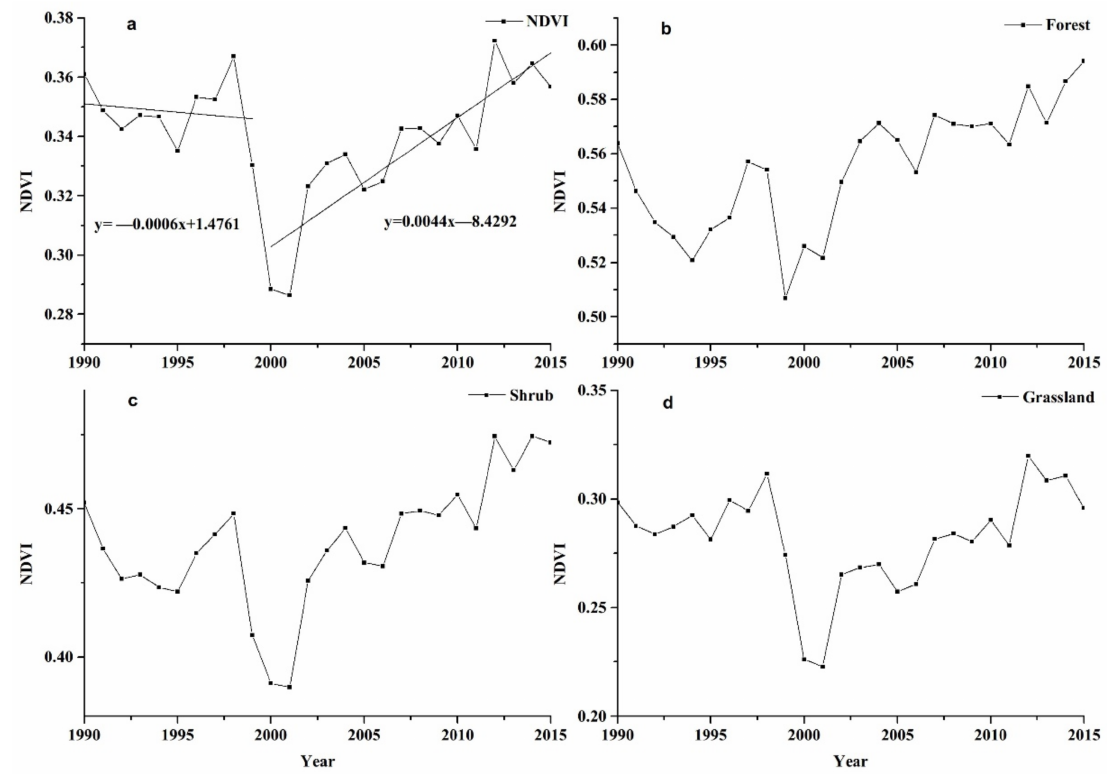
Figure 5. Interannual trend of the NDVI in the growing season from 1990 to 2015.